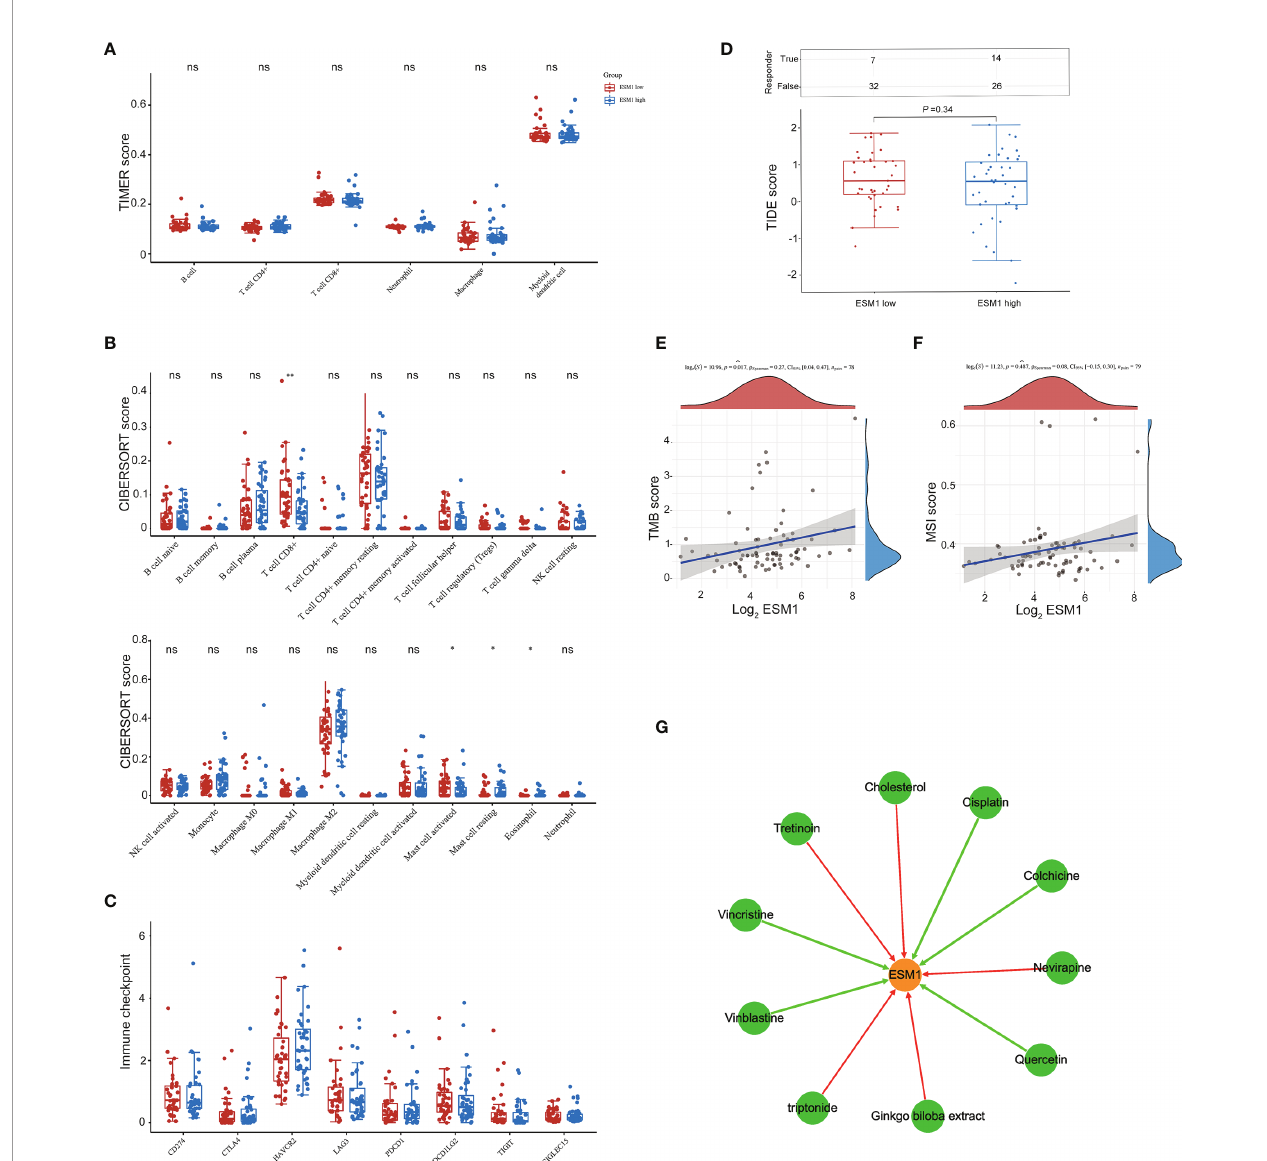
FIGURE 8 | The potential therapeutic strategies or available chemical drugs for the treatment of ACC. (A) Immune in fi ltration analysis, including TIMER score (A) , CIBERSORT score (B) , immune checkpoint-related genes (C) , TIDE score (D) , TMB score (E) , and MSI score (F) , of two subgroups including ESM1 high ( n = 40) and ESM1 low ( n = 39) samples in ACC patients. TIDE, tumor immune dysfunction and exclusion. The horizontal axis represents the gene expression distribution, and the vertical axis denotes the expression distribution of TMB/MSI score. The density curve on the right side represents the distribution trend of TMB/MSI score. The density curve of the upper part represents the distribution trend of genes. The value represents the correlation p -value, correlation coef fi cient, and calculation method. (G) The gene-drug interaction network of ESM1 and related chemotherapeutic drugs. Red arrows: chemotherapeutic drugs upregulate ESM1 expression; green arrows: chemotherapeutic drugs downregulate ESM1 expression. ns denotes no signi fi cant difference, * p < 0.05, ** p <